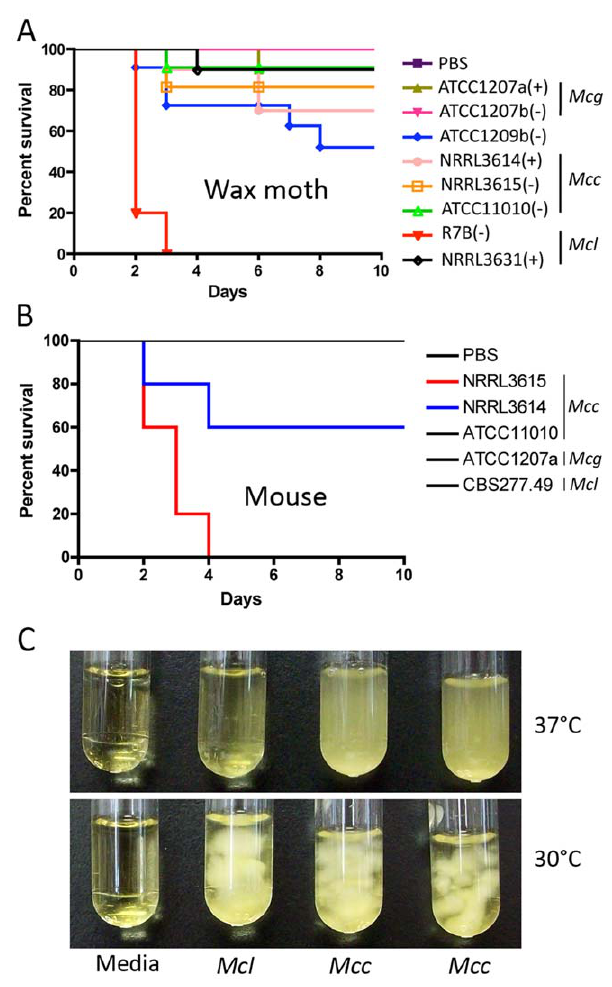
Figure 7. Virulence tests of the three M.circinelloides subspecies in the wax moth and murine hosts. (A) Larvae of the wax moth Galleria mellonella were used as the host. Mcl was found to be the most virulent, causing 100% mortality in 3 days. All other strains were less virulent. Injections were repeated three times with similar results. PBS injection served as a negative control. (B) Virulence of M. circinelloides subspecies in the murine host. Mice infected with NRRL3615 ( Mcc ) show 100% mortality in four days, and those with NRRL3614 ( Mcc ) show 40% mortality in four days. Both NRRL3615 and NRRL3614 are Mcc isolates that are commonly found in clinical isolates tested in this study. (C) Mcc (NRRL3614 and NRRL3615) exhibits more robust grows at 37 u C compared to Mcl (CBS277.49), which may result in Mcc being highly virulent in the diabetic murine host compared to Mcl , unlike our observations in the wax moth